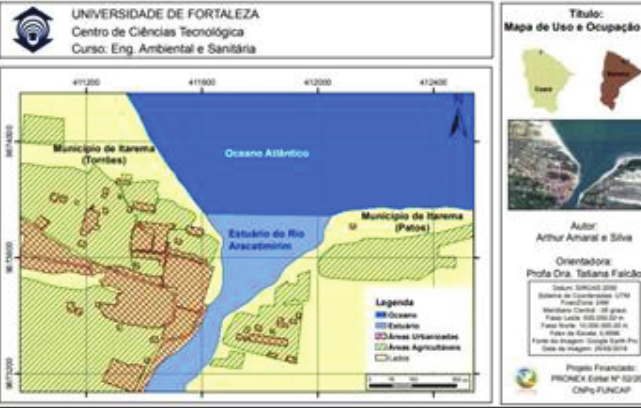
Figure 2 – Land use map of 2010